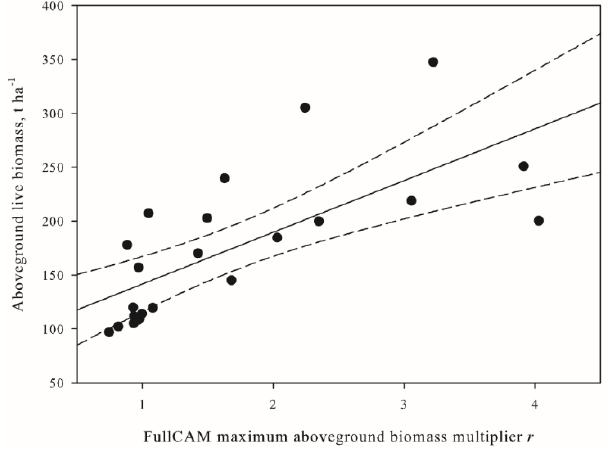
Figure 4. Maximum aboveground biomass multiplier ( r ) fitted to aboveground biomass (AGB) live using linear regression function. Dash lines are 95% confidence interval; Pearson correlation coefficient r = 0.712, p < 0.001. Calibration of r did not improve FullCAM predictions in total aboveground carbon. The aboveground debris pool (litter and CWD) remained significantly lower than the observed values and dead standing trees were not accounted in default settings of FullCAM (Figure 5).